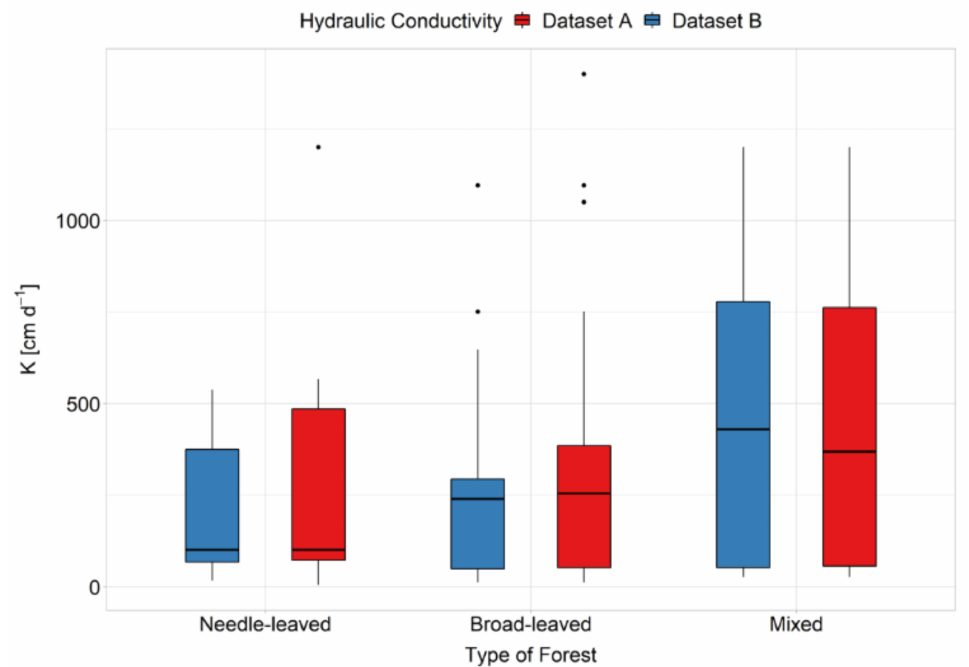
Figure 5. Descriptive statistics of topsoil hydraulic conductivity in terms of forest type considering two datasets: dataset A containing all values found and dataset B containing filtered values based on available information on tree age and soil particle size. All values refer to the topsoil (0–30 cm depth). Black dots represent the